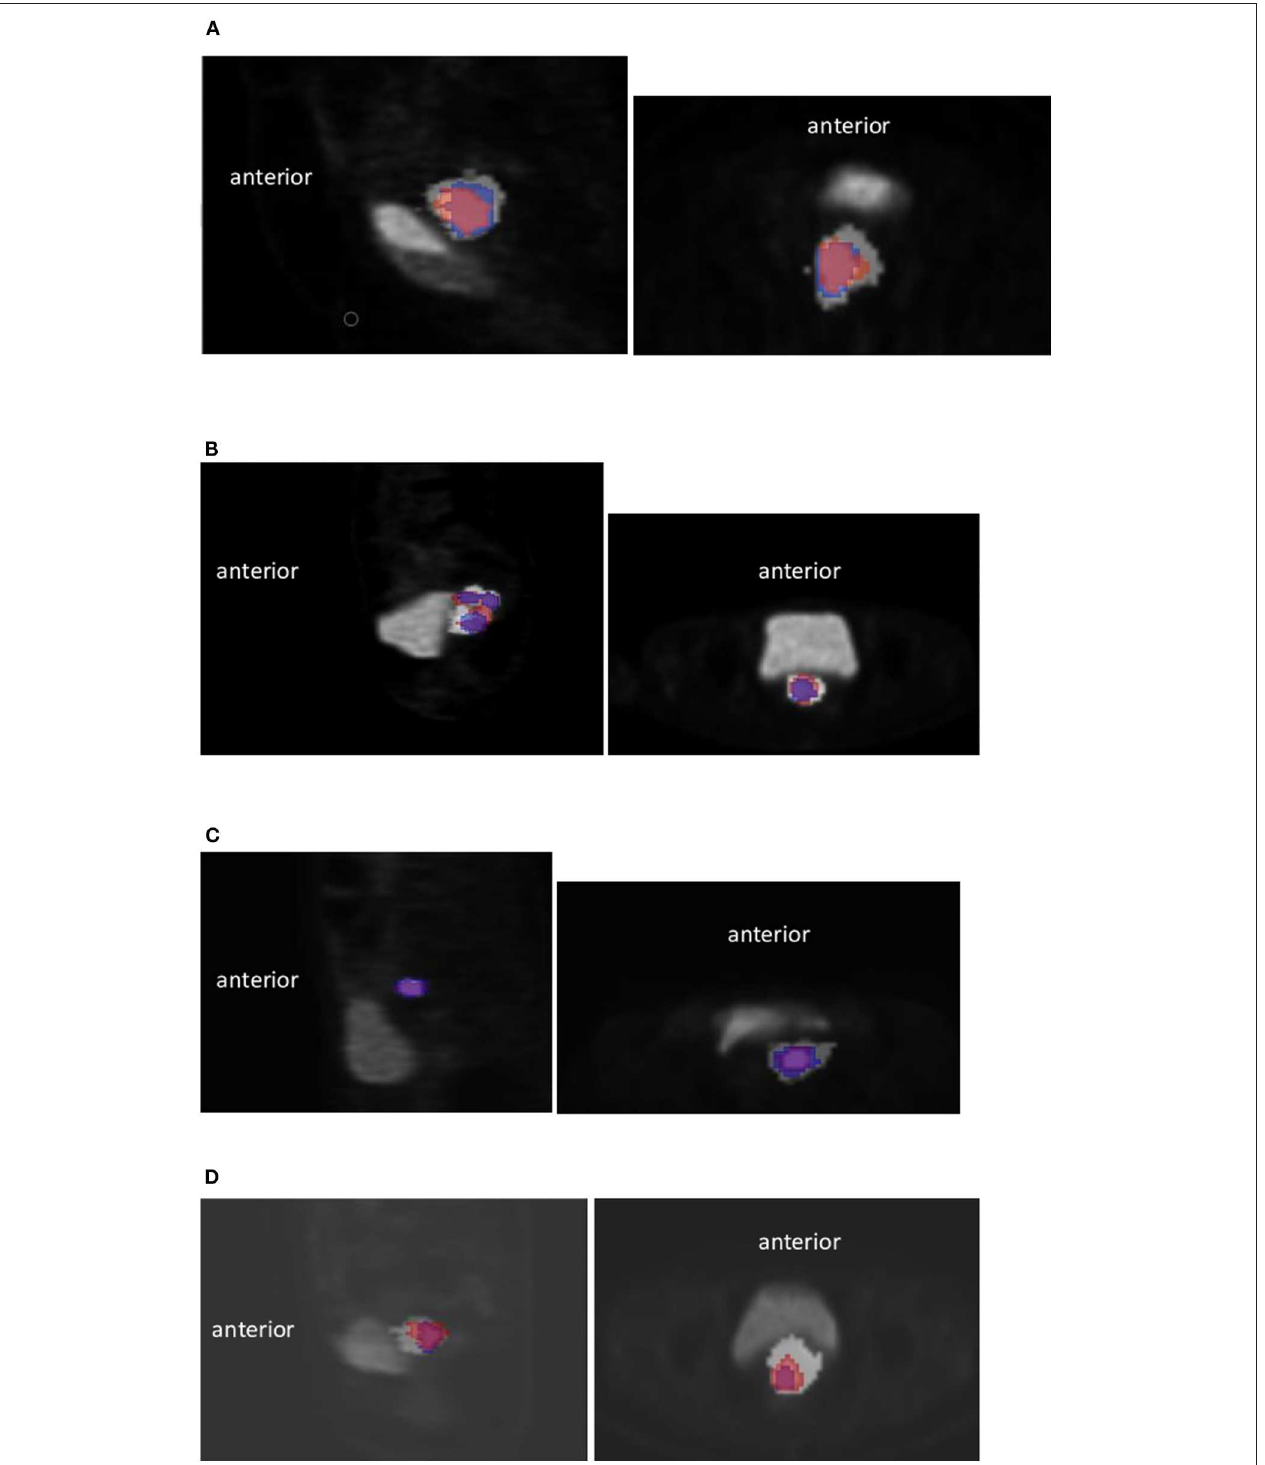
FIGURE 1 | Examples of registration using the 3D Slicer TM Expert Automated Registration module in 4 different patients. Initial high 18F-FDG uptake sub-volume (V1) in blue and relapse V2 in red. Sagittal view (left) and axial (right) (A) for this particular case, a manual correction of the registration due to a different bladder filling was necessary (Dice = 0.73, OF = 0.77, X = 0.70, Y = 0.77), (B) Case with V2 larger than V1 (Dice = 0.62, OF = 0.80, X = 0.80, Y = 0.50), (C) Case with small V1 and V2 (Dice = 0.72, OF = 0.82, X = 0.64, Y = 0.82), (D) Case with V2 larger than V1 (Dice = 0.76, OF = 0.90, X = 0.90, Y = 0.65).